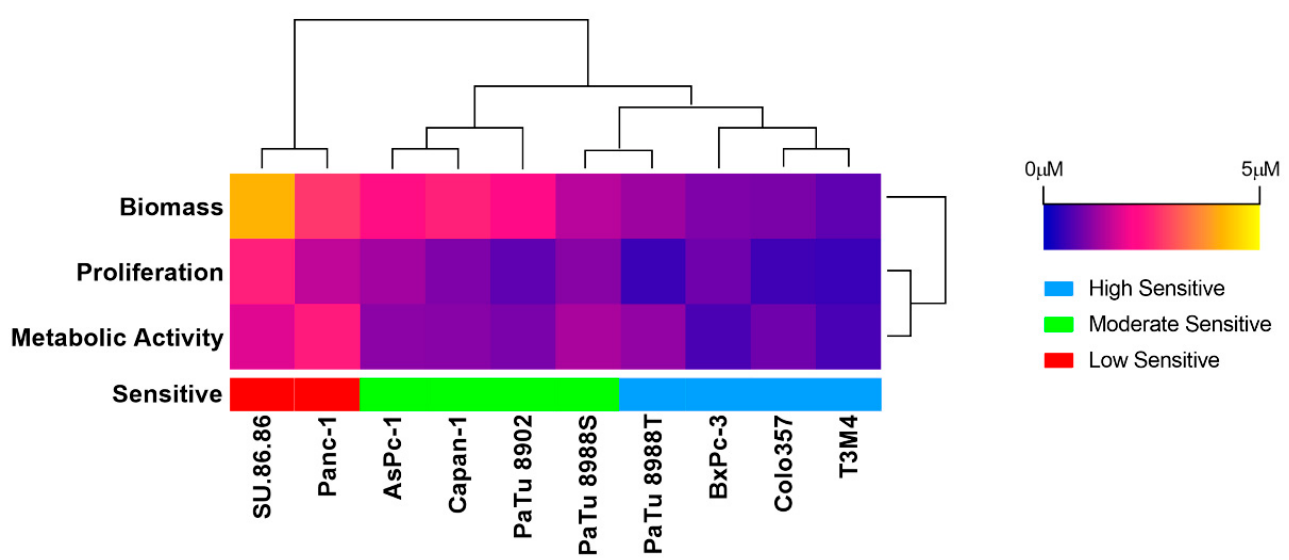
Figure 2. IC50 values when assessing proliferation, metabolic activity, and cell biomass after 72 h Buparlisib exposure in ten PDAC cell lines, as well as the classification of these cell lines by k- means++ (unsupervised machine learning algorithm) into low (red), moderate (green), and high sensitivity (blue) groups.